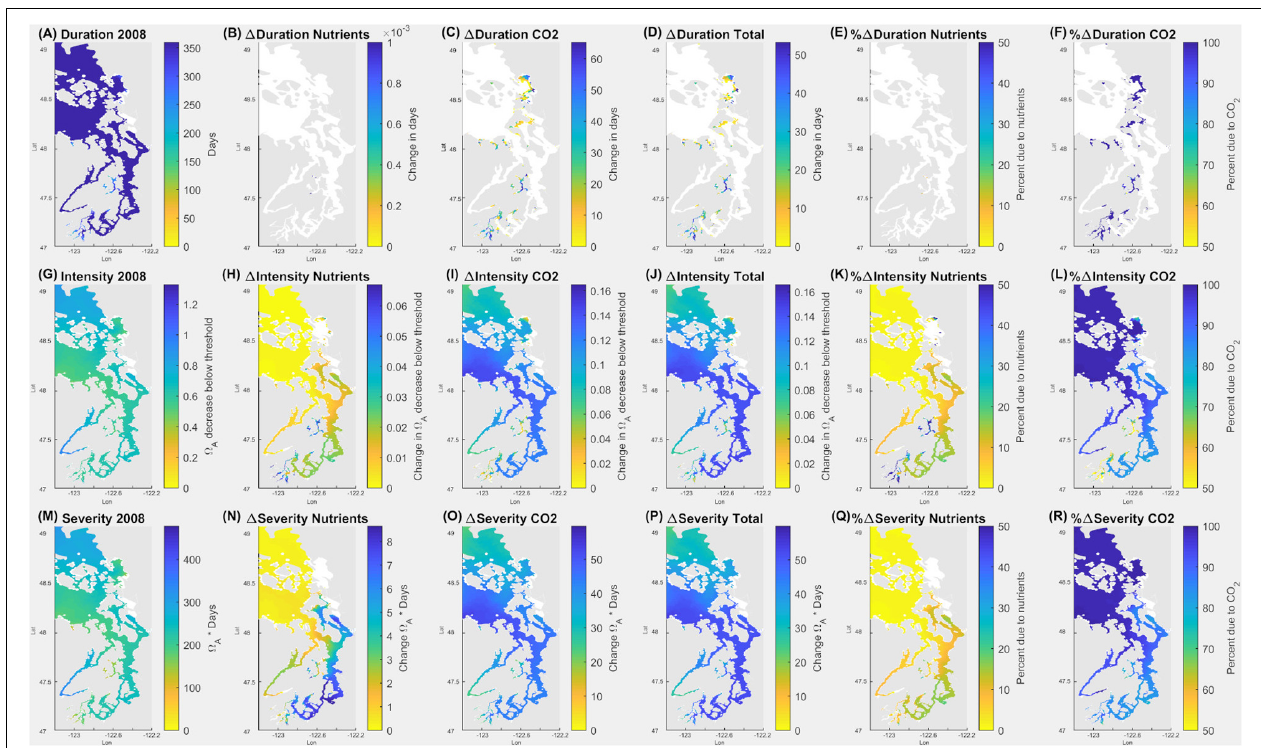
FIGURE 6 | Application of pteropod threshold for mild dissolution (5 days at (cid:127) ar = 1.5) over the annual scale in the upper 100 m in the Salish Sea. Model outputs demonstrate current (2008) duration, intensity, and severity of the conditions (A,G,M) . The second column indicates all the changes due to nutrients (B,H,N) ; the third column is related to the changes due to atmospheric CO 2 (C,I,O) ; and the fourth column (D,J,P) shows total changes due to both nutrients and atmospheric CO 2 . The fifth column (E,K,Q) depicts % changes in (cid:127) ar due to nutrients, and the sixth column (F,L,R) is the % change in (cid:127) ar due to atmospheric CO 2 . Values of zero are masked in